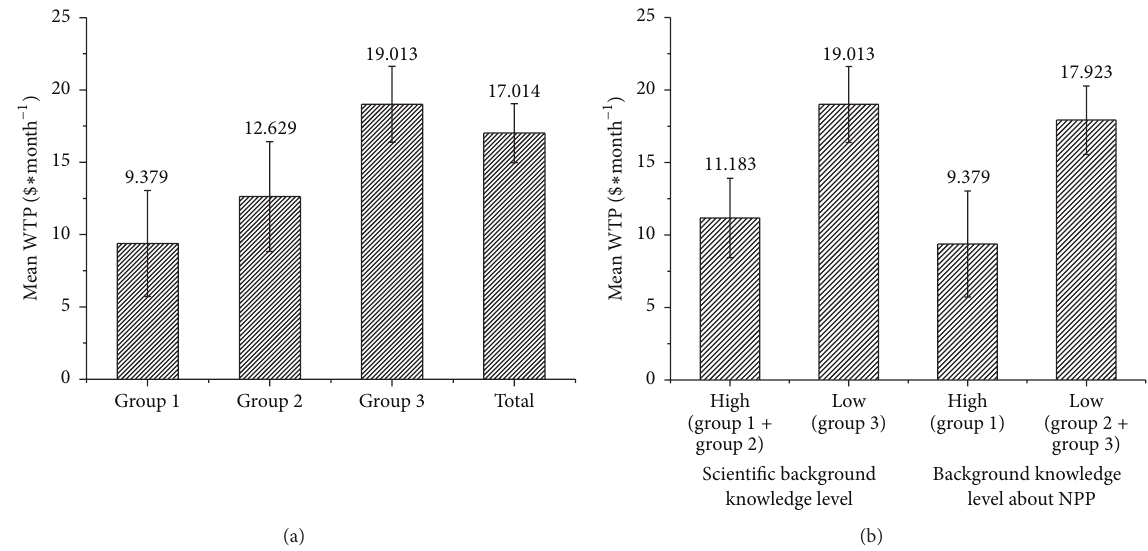
Figure 3: Mean WTP comparison according to (a) scientific knowledge level (group number) and (b) type of scientific knowledge (group number).